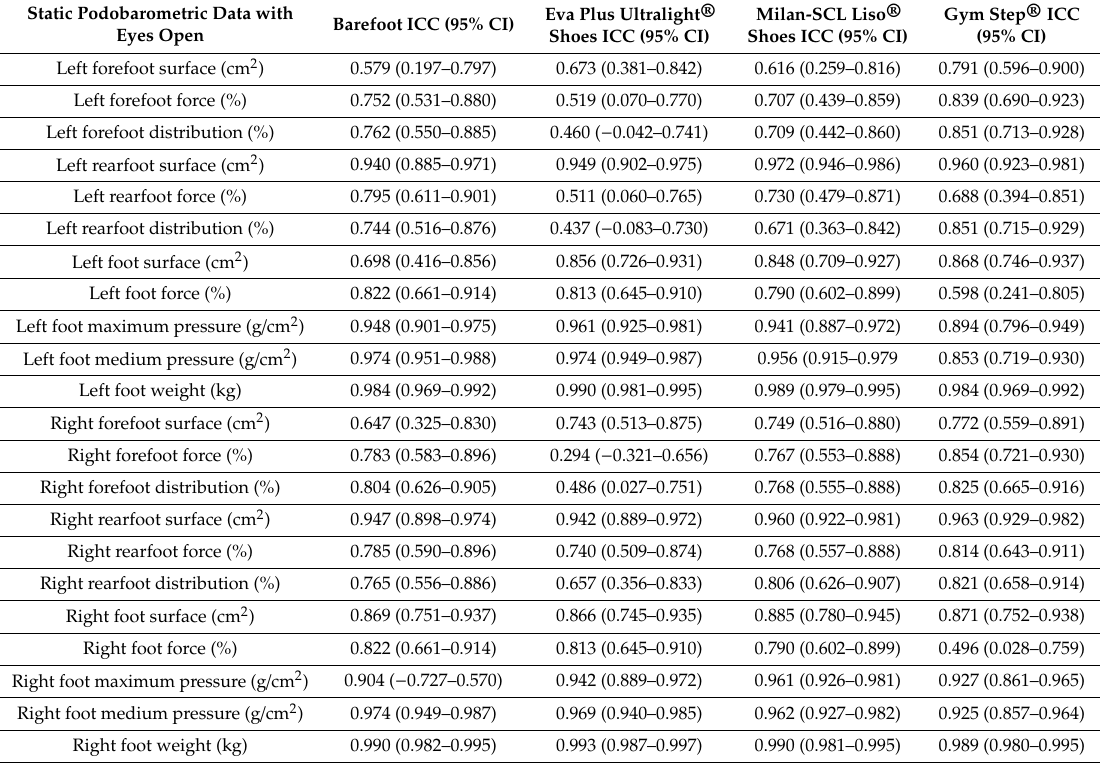
Table 2. Reliability of the static podobarometric data with eyes open.